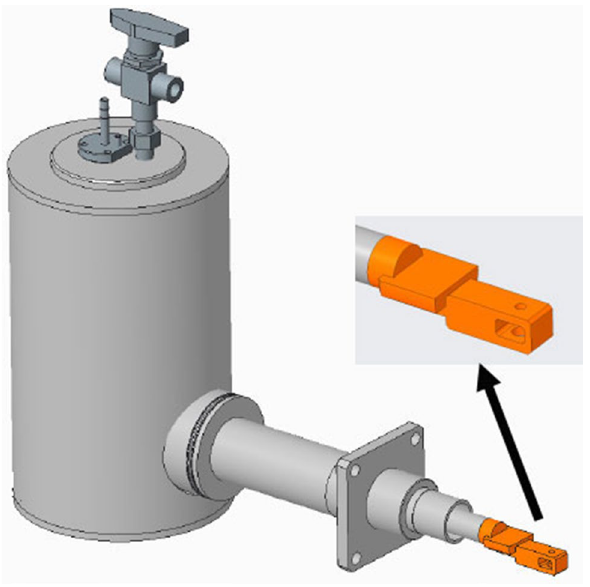
Figure 1. Schematic of the anti-contamination trap. The inset shows an enlarged view of the